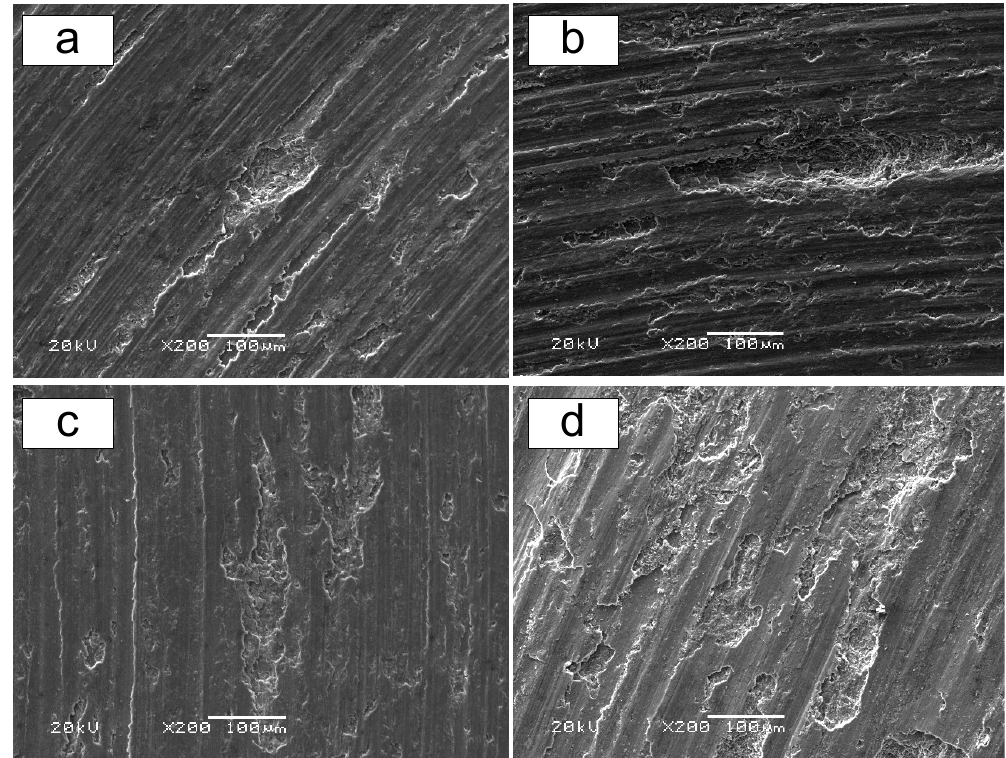
Figure 6. Scanning electron micrographs of worn surfaces under a sliding velocity of 0.50 m/s and loads of 2.5 and 5.0 N. ( a , c ) Worn surfaces of Al–12Si–CuNiMg matrix alloy under loads of 2.5 and 5.0 N, respectively. ( b , d ) Worn surfaces of Al 2 O 3 fiber-reinforced composite under loads of 2.5 and 5.0 N,